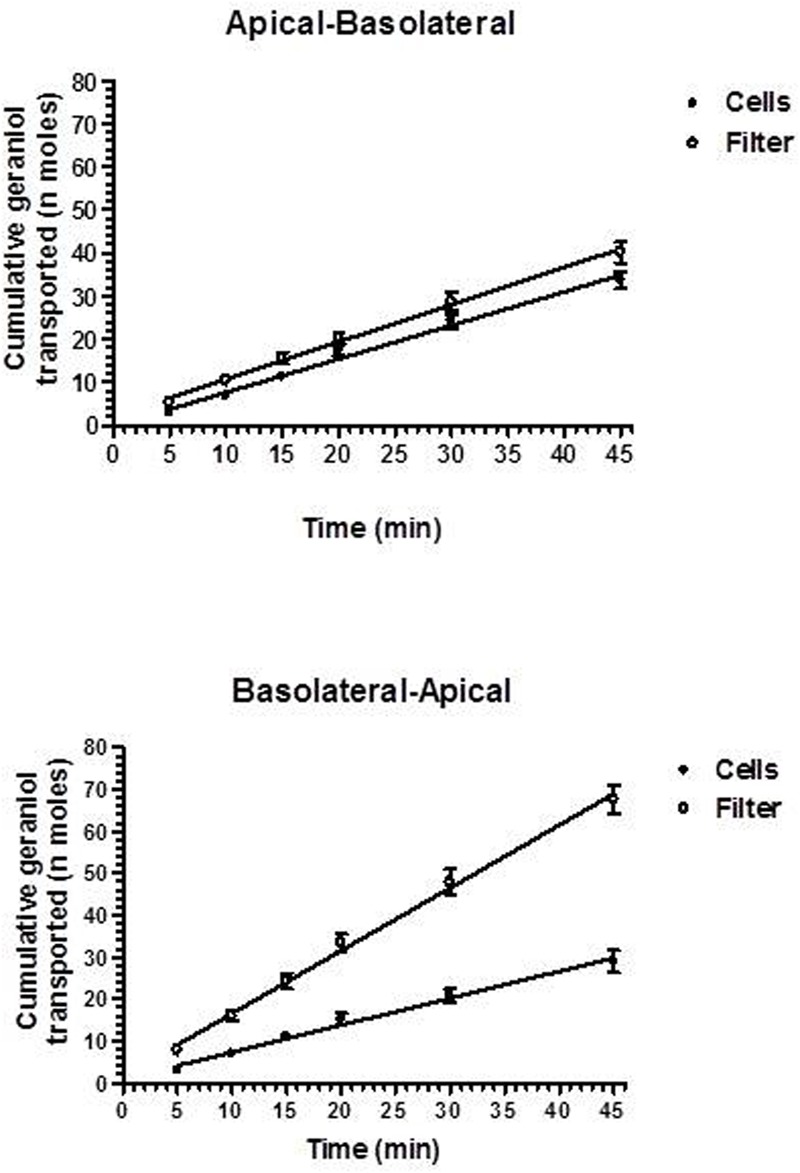
Permeation kinetics of 500 μM geraniol across the Millicell filters alone (filter) or covered by monolayers obtained from NCM460 cells. The permeations were analyzed from the apical to basolateral compartments and from the basolateral to apical compartments. In all cases analyzed, the cumulative amounts in the receiving compartments were linear over time within 45 min (r ≥ 0.994, P ≤ 0.0001). All data are reported as mean ± SE of four independent experiments.